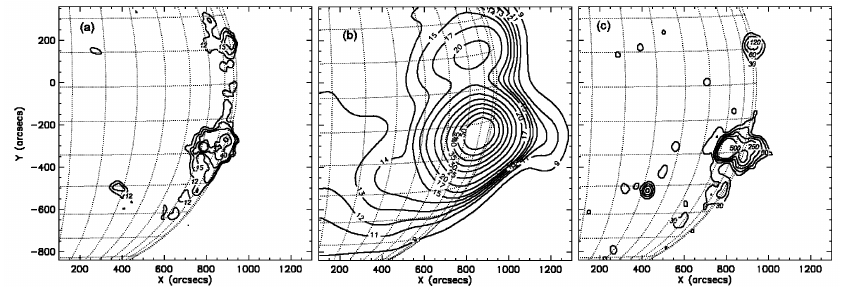
Fig. 5. The Stokes I parameter maps of NOAA 11519{11521 obtained with (a) NoRH at 1.76 cm on 2012-07-17 UT 6:05, (b) VIRAC RT-32 at 3.76 cm on 2012-07-17 UT 7:15, (c) SSRT at 5.2 cm on 2012-07-17 UT 2:44. Levels are presented in 10 3